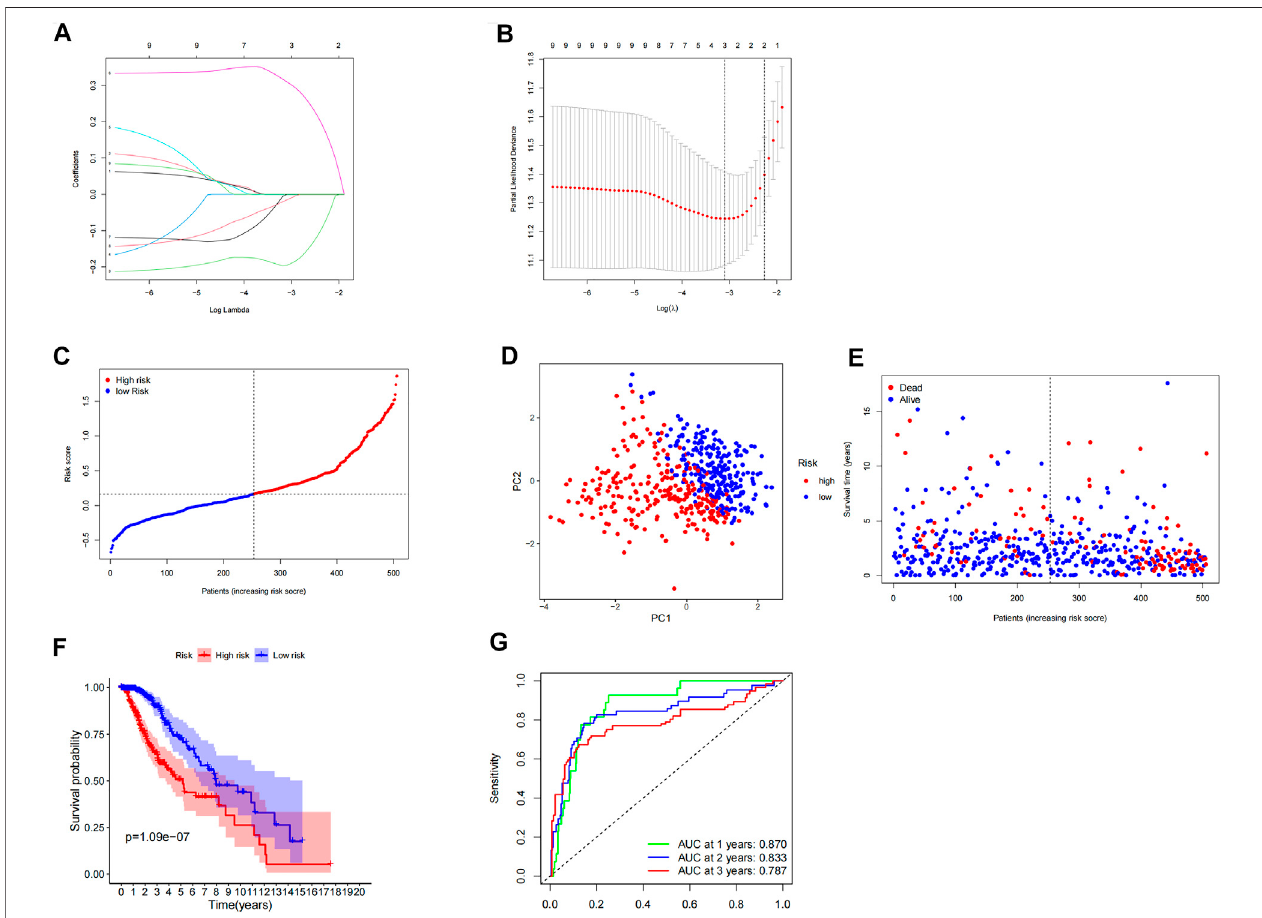
FIGURE 2 | Construction and evaluation of prognostic model of in fl ammation-related genes. (A,B) LASSO Cox regression analysis screened three differentially expressed in fl ammatory genes and established a prognostic model. (C) Risk curve constructed according to the median of the risk score. (D) Feasibility of PCA-based analysis and judgment models. (E) Survival status of LGG patients with different risk scores. (F) Survival analysis of LGG patients in different risk groups. (G) ROC curve suggested that the model had good accuracy in predicting the 1-year, 3-year, and 5-year survival of LGG patients.